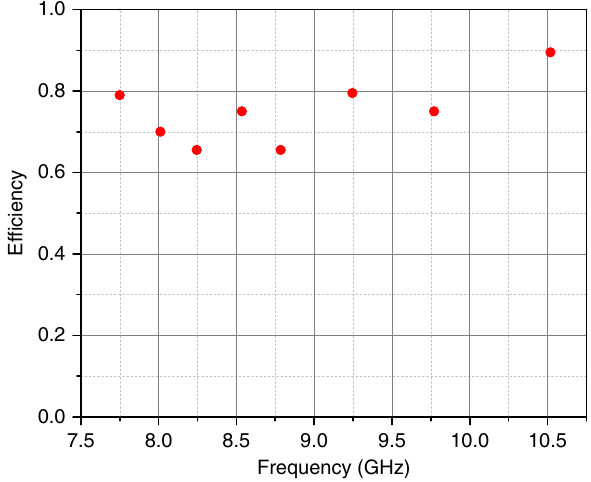
Figure 5 | The single-photon source efficiency in a wide frequency range. The extracted efficiency of the photon source versus different transition frequencies of the two-level